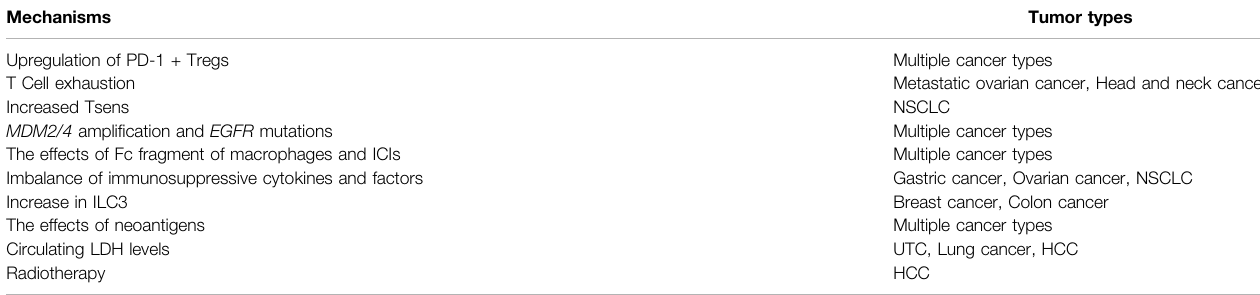
TABLE 2 | Potential mechanisms of HPD in different types of